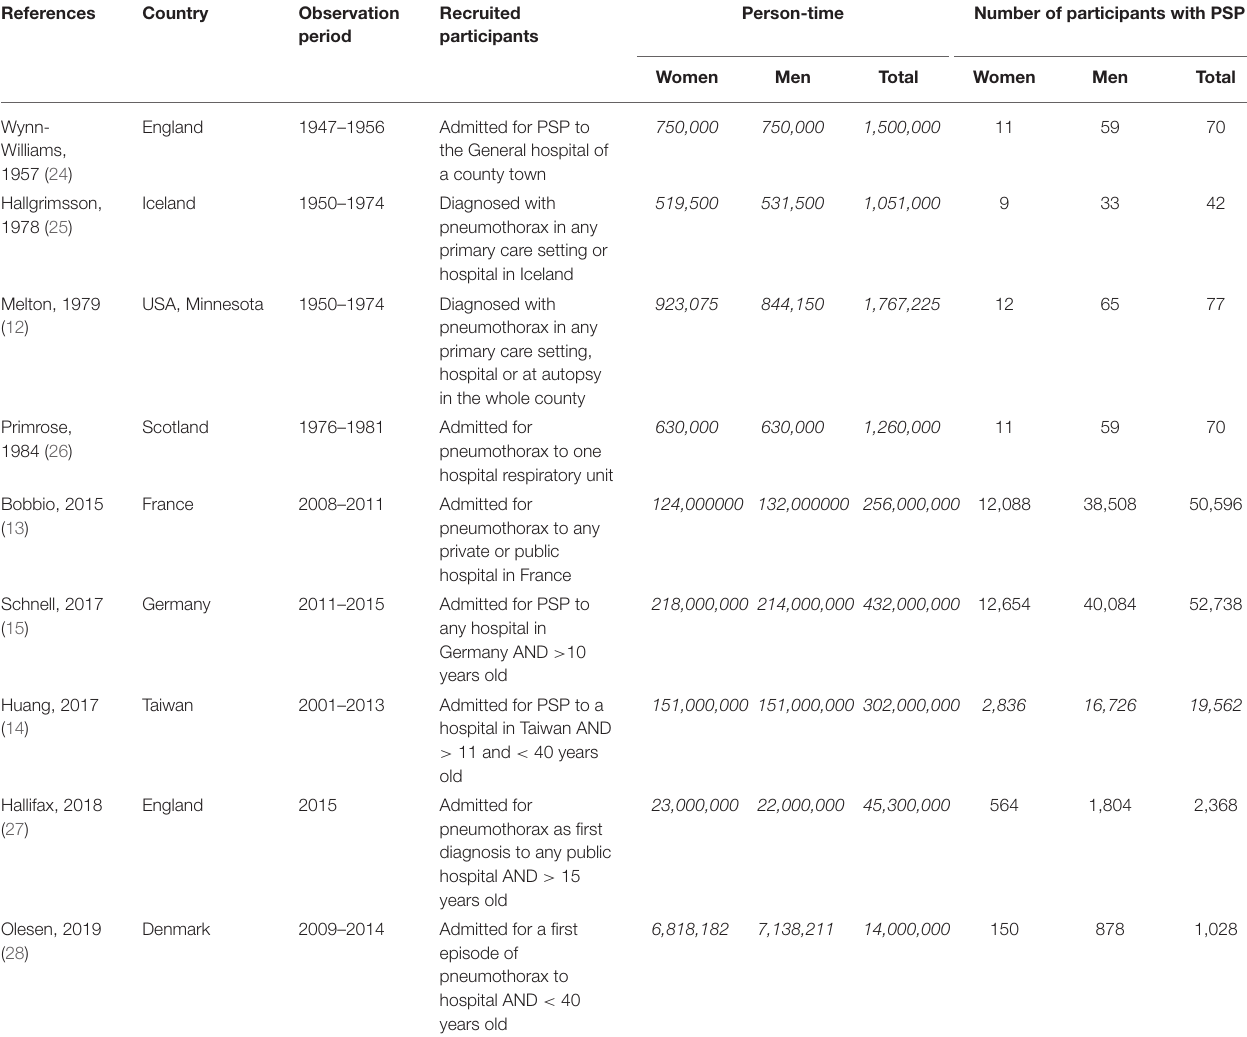
TABLE 3 | Studies reporting the incidence of primary spontaneous pneumothorax in the general